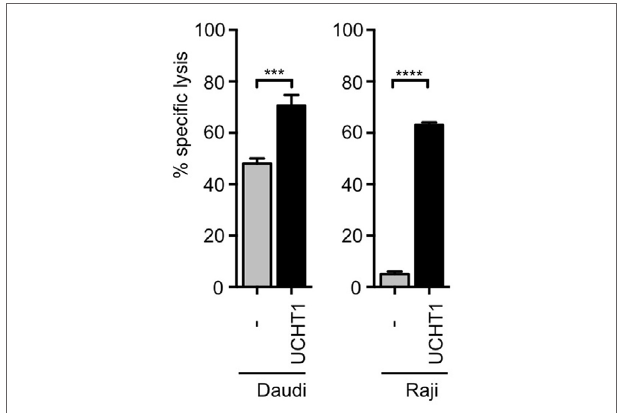
FigUre 1 | UCHT1 increased tumor killing by γδ T cells. 51 Cr-labeled Daudi and Raji cells were incubated with zoledronate-expanded human γδ T cells without ( − ) or with the addition of 5 µg/ml UCHT1 using an effector to target (T cell to tumor cell) ratio of 12.5:1. After 5 h of co-culture, the amount of released 51 Cr was measured in the supernatant by γ -ray spectroscopy. Data represent mean ± SD of triplicate wells ( n = 3). Significance was determined by unpaired t -test, two-tailed between untreated γδ T cells and treated